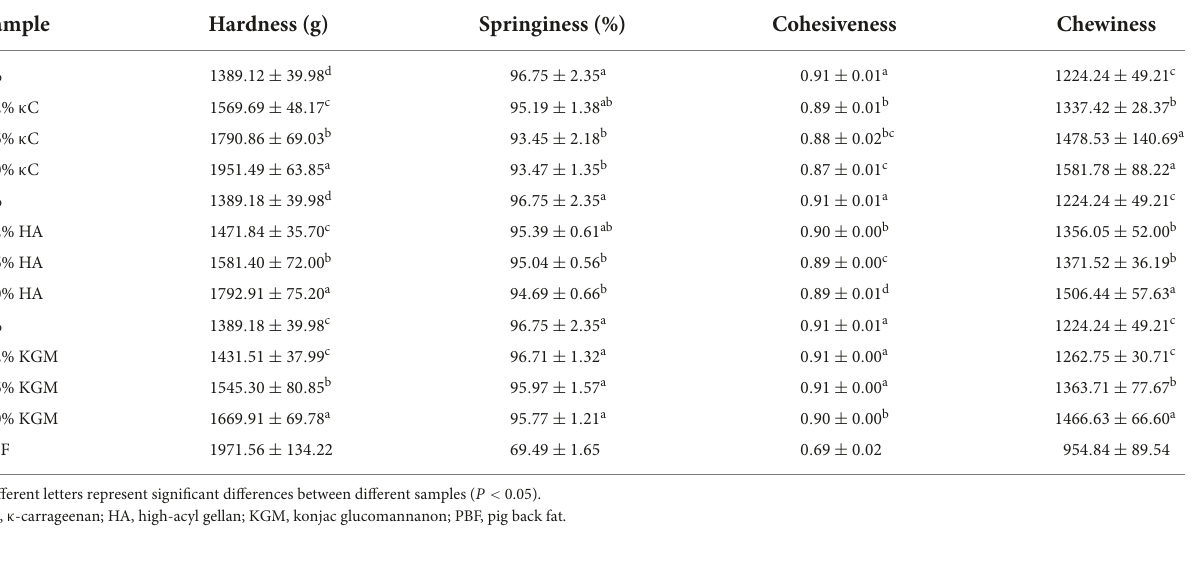
TABLE 1 The texture profile analysis (TPA) data of emulsion gels containing different polysaccharides.